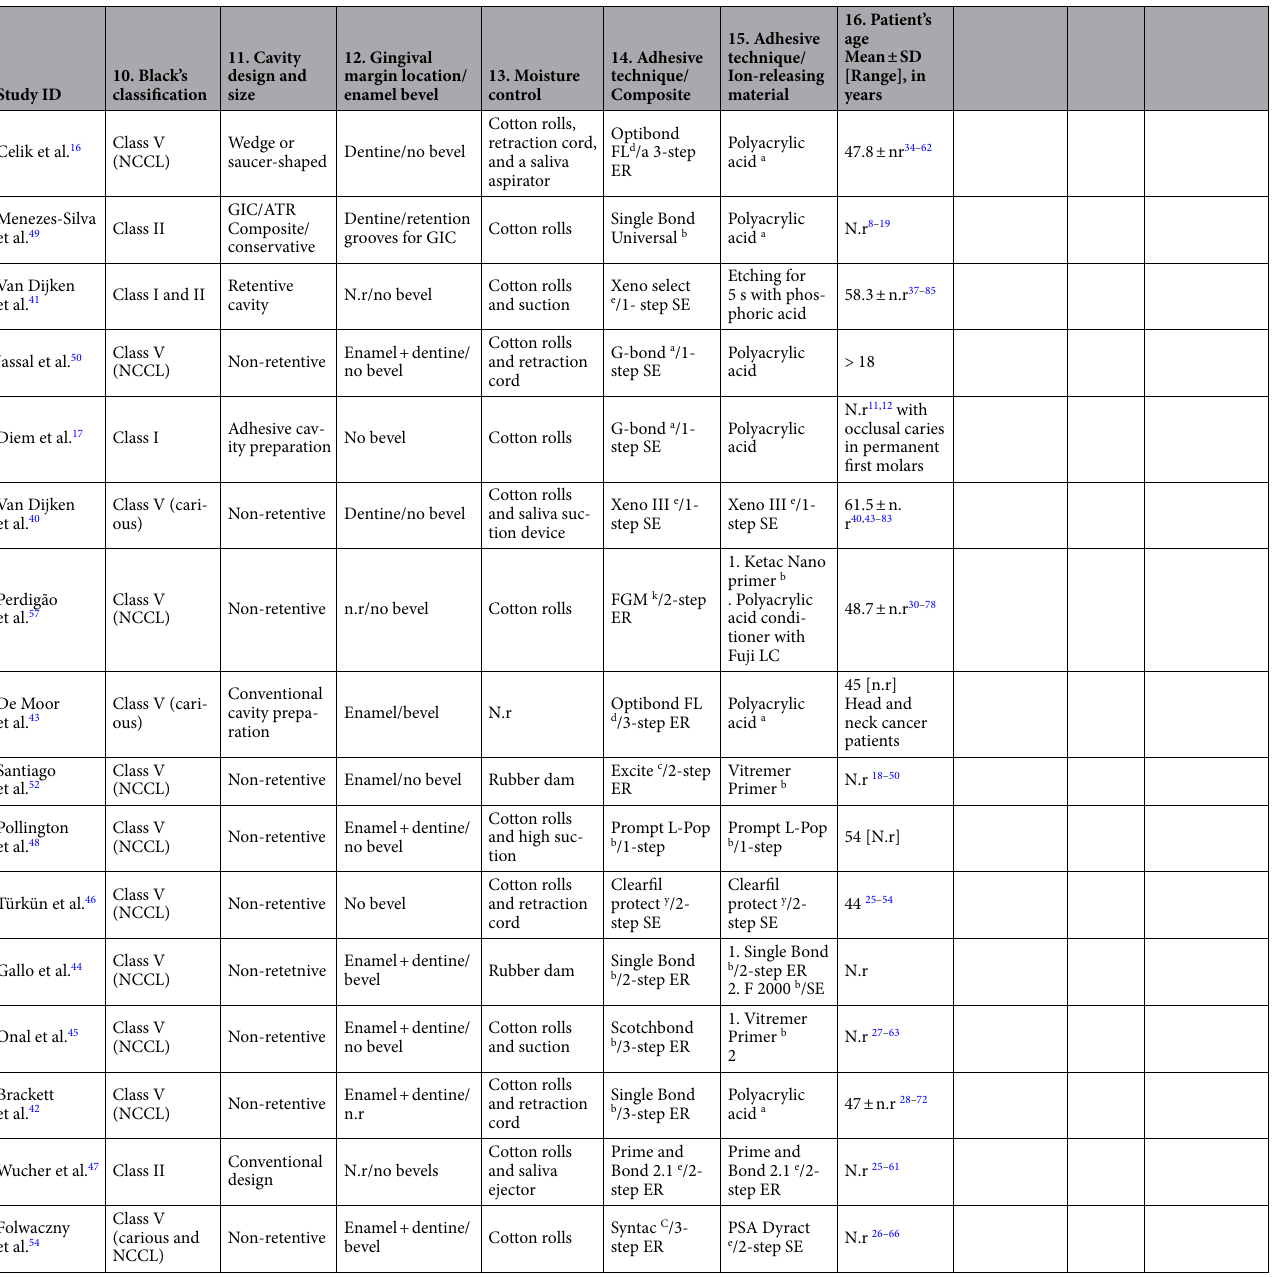
Table 1. Characteristics of the included studies. a: GC,Tokyo, Japan, b: 3 M. c: Heraeus Kulzer, Ha-nau, Germany. d: Kerr—Sybron Gmbh, Karlsruhe, Germany. e: Dentsply,Konstanz, Germany. C: Vivadent,